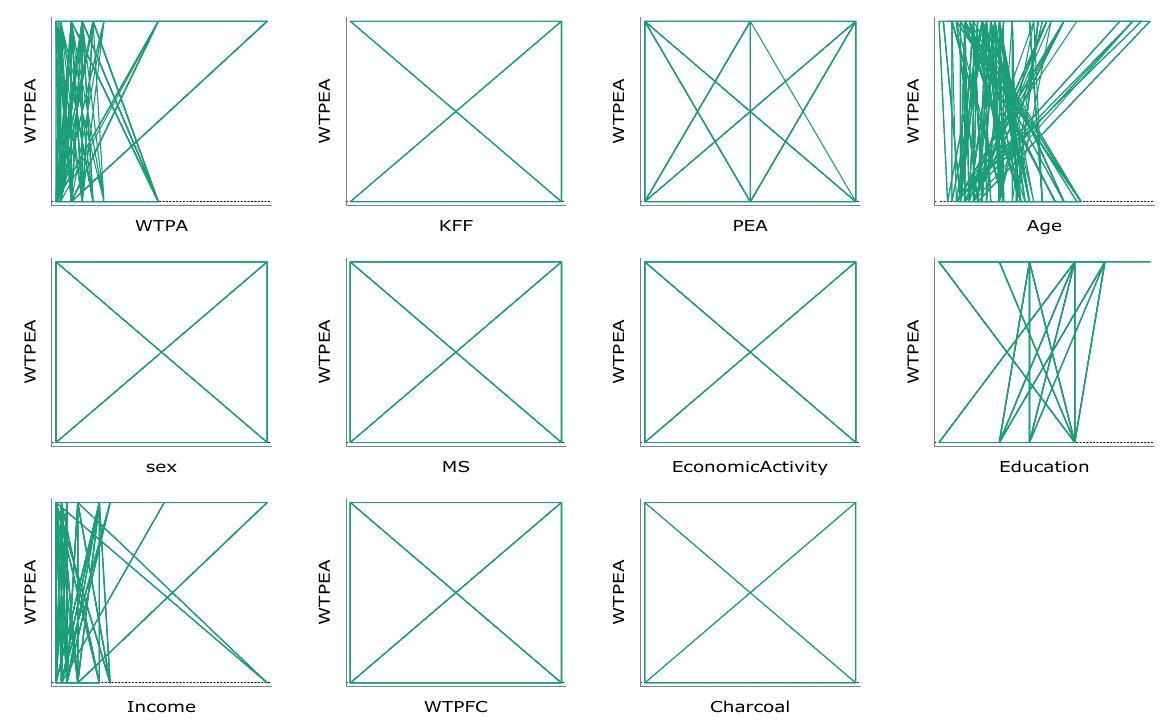
Figure 7. Plot of the WTPEA against other variables.